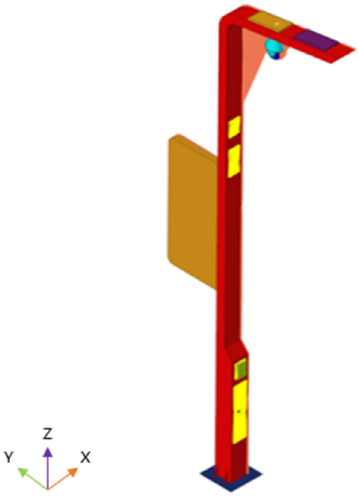
Figure 3: The fi nal model of the smart pole.